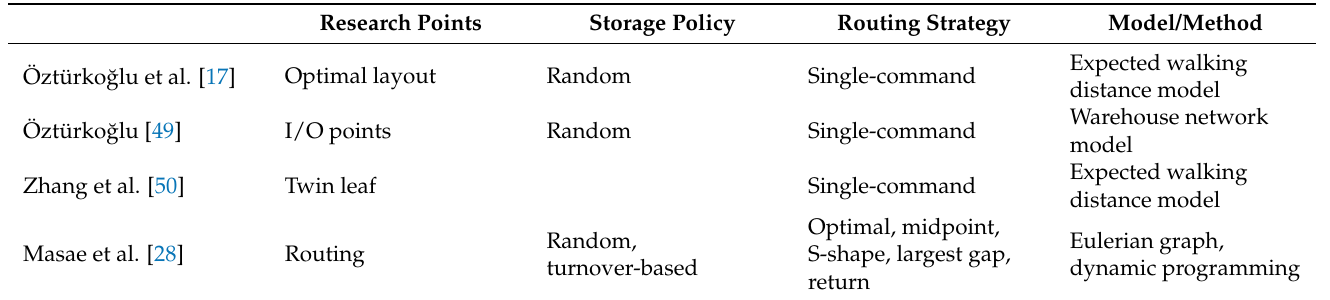
Table 1. The existing literature on the leaf